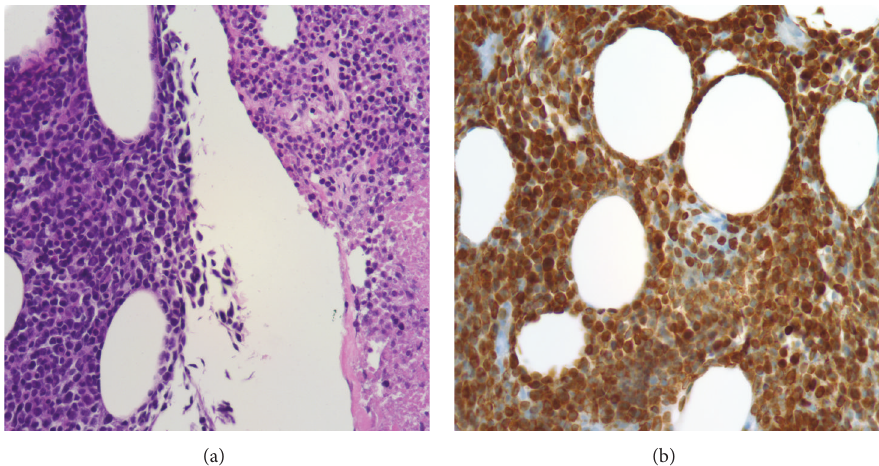
Figure 4: Histomorphologic and immunohistochemical analysis. (a) Relatively monotonous population of atypical lymphocytes infiltrating in adipose tissue with round to angulated nuclei, condensed nuclear chromatin, and inconspicuous nucleoli. The right side shows the same population of cells from the left in various stages of necrosis (H&E stained, formalin fixed, paraffin embedded section, at 40x magnification). (b) Immunohistochemical stain for CD79a, a B-cell specific antigen (formalin fixed, paraffin embedded section, at 40x magnification).